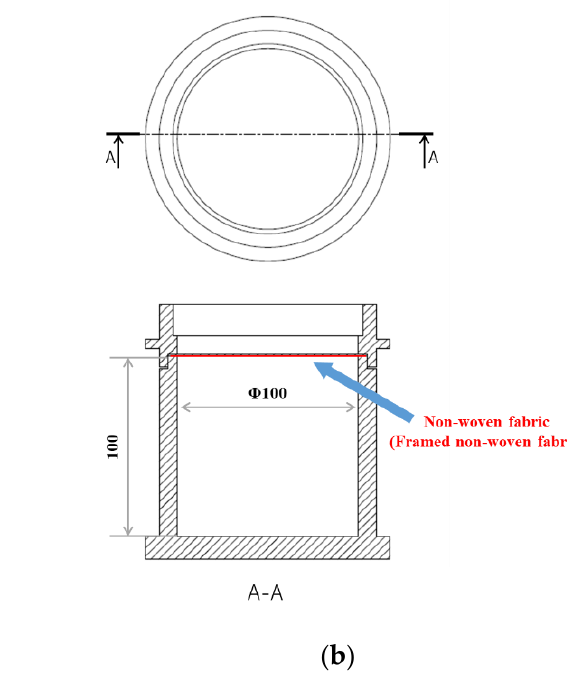
Figure 4. Sample tube: ( a ) photograph; ( b ) dimensions.